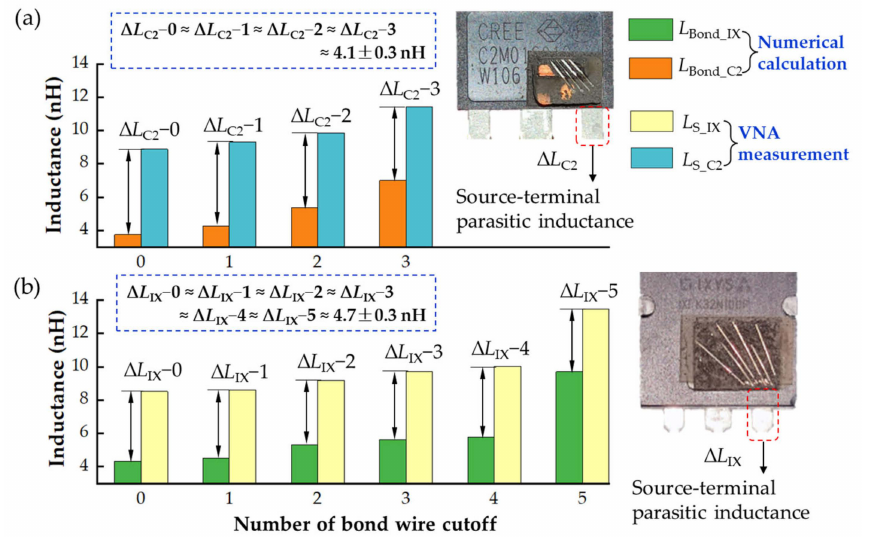
Figure 15. Numerical calculation and VNA measurement of parasitic inductance with different cutoff numbers of bond wires. ( a ) Comparison results of C2M0160120D. ( b ) Comparison results of